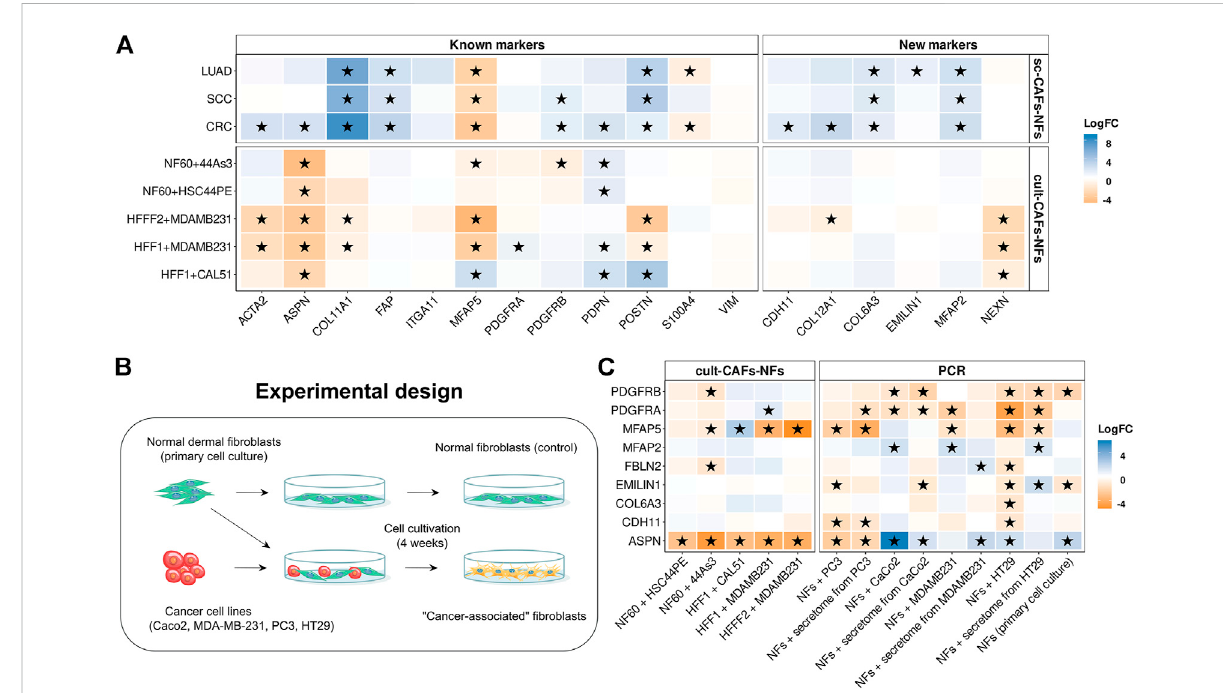
FIGURE 5 Comparison of gene expression between fi broblasts cultured with cancer cell line and mono-cultured fi broblasts. (A) Heatmaps showing differencesinthegeneexpressionlevelinCAFsrelativetoNFsinsc-CAFs-NFsandcult-CAFs-NFsapproaches.Ontheleftisaheatmapforcommon CAF marker genes, and on the right for our proposed CAF marker genes. Asterisks indicate signi fi cant differences in the expression ( | logFC | ≥ 1 and FDR < 0.05). Blue = increased gene expression in CAFs compared to NFs, orange = decreased gene expression in CAFs compared to NFs. (B) Experimental design for comparing the expression of the proposed CAF marker genes between normal fi broblasts cultured in the presence and absence of cancer cell lines. (C) Heatmaps showing differences in the proposed CAF marker gene expression level in CAFs relative to NFs, based on theanalysisofpubliclyavailabledata(cult-CAFs-NFsapproachdata)andtheresultsofourexperiment(PCR).Asterisksindicatesigni fi cantdifferences intheexpression( | logFC | ≥ 1andFDR < 0.05forcult-CAFs-NFsapproach, | logFC | ≥ 1andpvalue < 0.05forbulk-CAFs-NFsapproach).Blue=increased geneexpression inCAFscomparedtoNFs,orange=decreased geneexpressioninCAFscomparedtoNFs.Typesoftumor:CRC-colorectal cancer, LUAD — lung adenocarcinoma, SCC — squamous cell carcinoma, HNSC — head and neck squamous cell carcinoma, DGC — diffuse-type